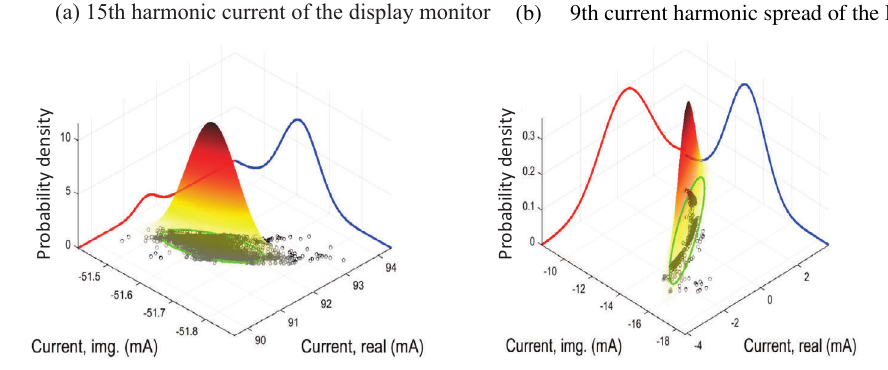
Fig. 2. Joint probability distribution applied to harmonic currents drawn by the monitor and PC [23].